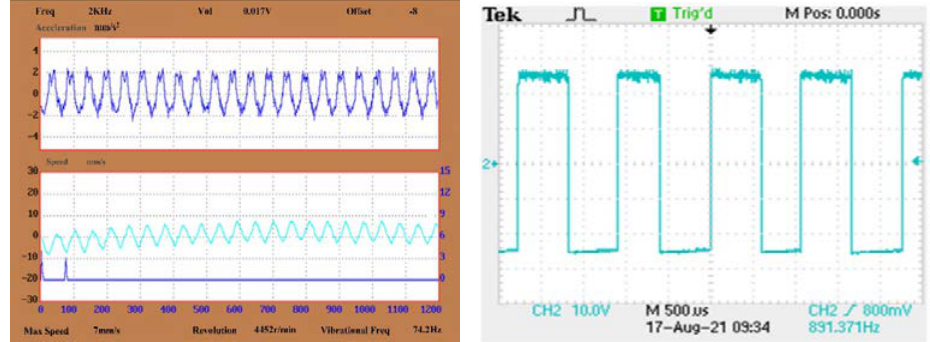
Figure 7. Field analysis results. Figure 8. The Waveform of the Hall